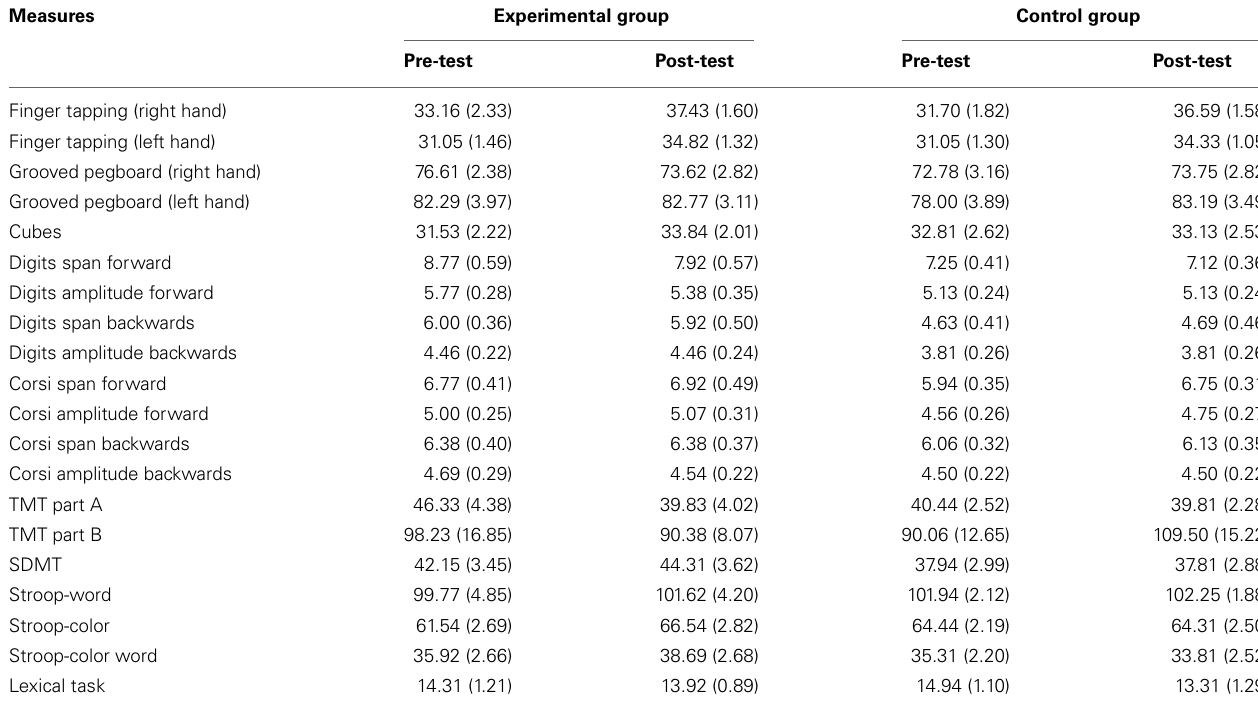
Table 4 | Means ( SE ) for all test that measure attention, executive function, and motor